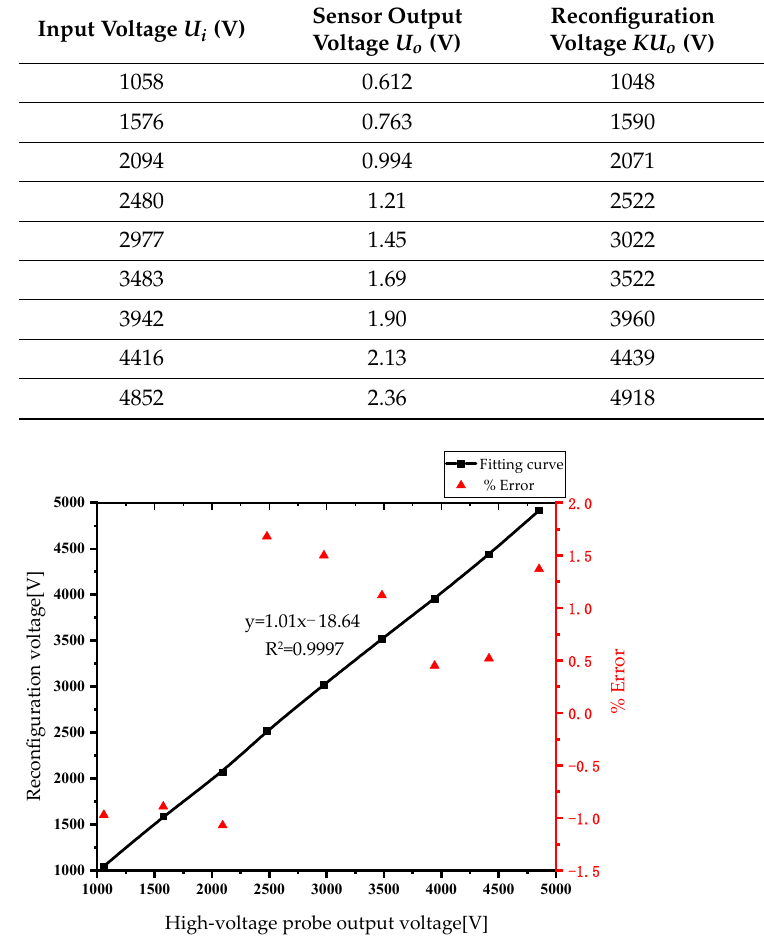
Figure 20. Sensor linearity and accuracy under high-voltage scenario. In Figure 20, the horizontal axis represents the output voltage value of the high-volt- age probe, which is the actual voltage value 𝑈 𝑖 of the tested circuit. The left axis repre- sents the reconstructed voltage value 𝐾𝑈 𝑜 based on the sensor output, and the right axis represents the ratio error between the reconstructed voltage value and the actual voltage value. From the graph, it can be seen that the linear relationship is y = 1.01x − 18.64 (y represents the reconstructed voltage, and x represents the actual voltage of the line), with a fi tt ing degree of 0.9997. Therefore, the sensor can measure the voltage value to be meas- ured in high-voltage scenarios with good linearity and measurement error within 2.0%.